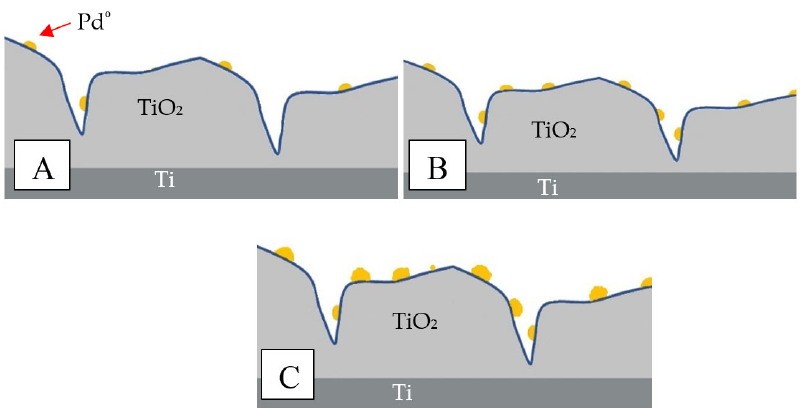
Figure 8. Comparison of catalytically active sites with different amounts of Pd: ( A ) 0.02% wt., ( B ) 0.2% wt., ( C ) 2% wt.